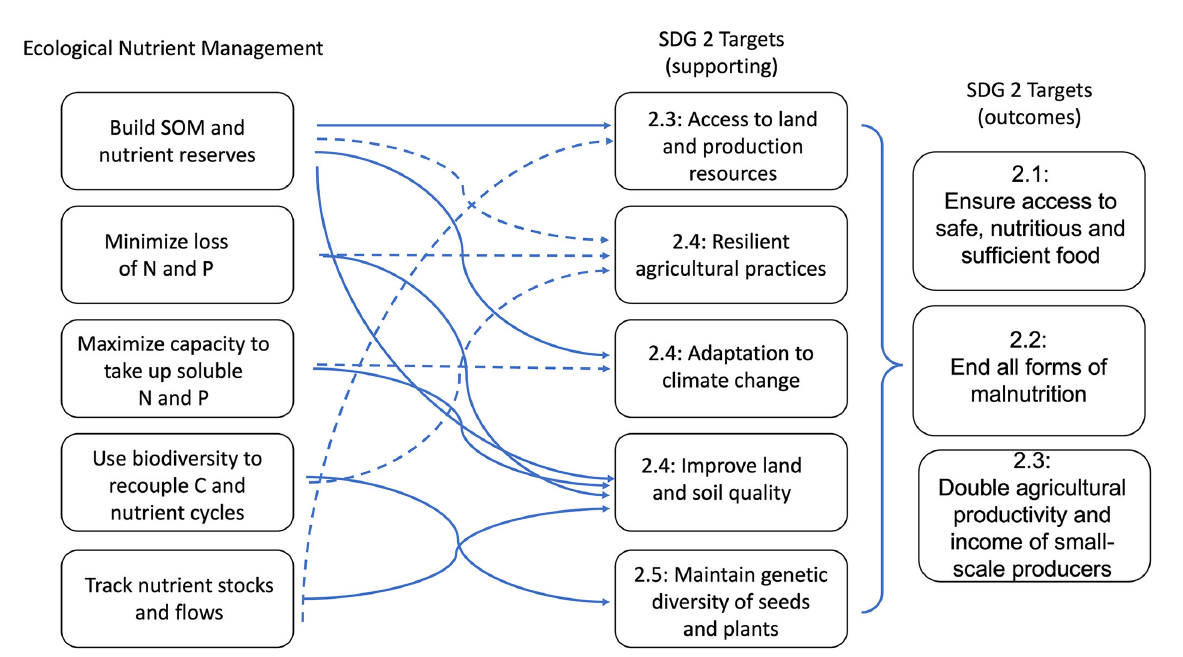
FIGURE1 Conceptual diagram showing pathways that link Ecological Nutrient Management (ENM) to the 5 targets of the second Sustainable Development Goal (SDG 2, Zero Hunger). In their review, Drinkwater and Snapp introduce five key principles of ENM (left side) : (1) build soil organic matter (SOM) and associated nutrient reserves; (2) minimize the soluble pools of nitrogen (N) and phosphorus (P) that are vulnerable to loss; (3) maximize the capacity for agroecosystems to take up and cycle soluble nutrients; (4) increase biodiversity to maximize the presence of growing plants and recouple C, N, and P cycles; and (5) use mass balances to assess net nutrient stocks and flows over multiple growing seasons. We show the links between these principles and the five SDG 2 targets, which are organized into two columns, “supporting” and “outcomes.” This distinguishes the components of the five targets that are intended to support high-level outcomes for SDG 2, shown at the far right of the diagram. Solid arrows show direct links between ENM principles and supporting targets of SDG 2, while dashed arrows show indirect links. These links include: Building SOM and nutrient reserves directly improves production resources and soil quality, and indirectly contributes to resilient systems by enhancing nutrient cycling and provisioning, reducing the need for external inputs, and buffering agroecosystems against drought and flooding. Minimizing losses of N and P directly improves land and soil quality by maintaining nutrient stocks in soils, and indirectly increases the resilience of agricultural practices by increasing the efficiency of nutrient inputs and reducing pollution of